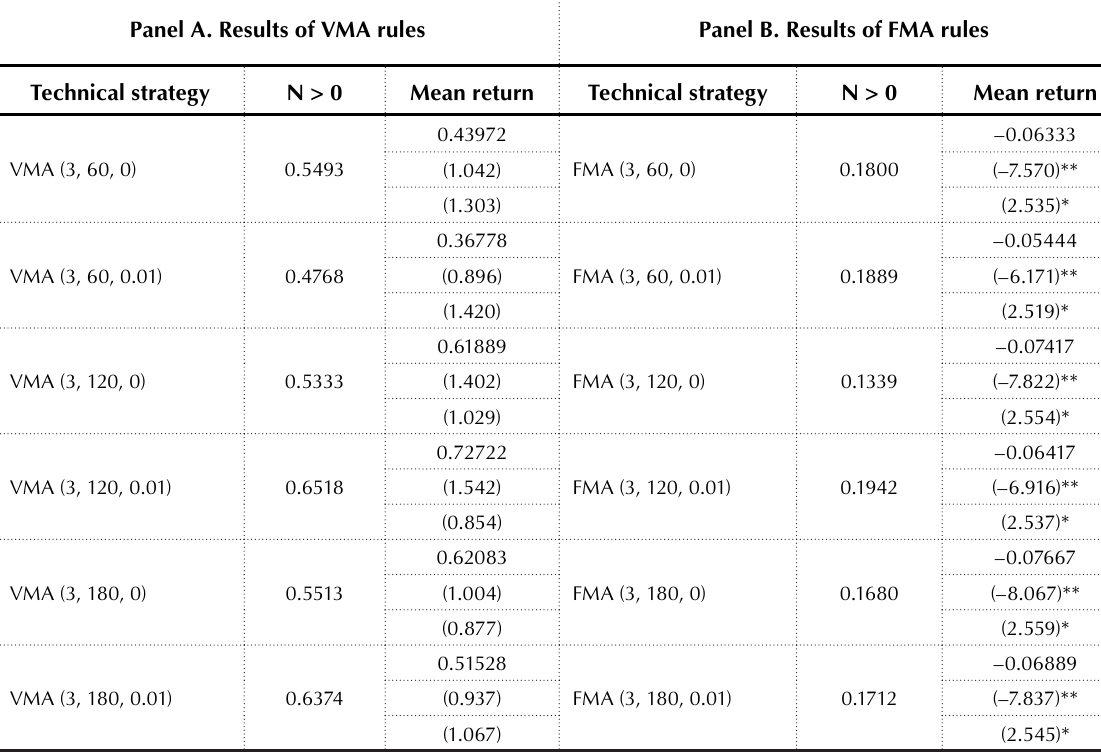
Table 1. VMA and FMA trading performance before the global financial crisis (2005–2007) Panel A. Results of VMA